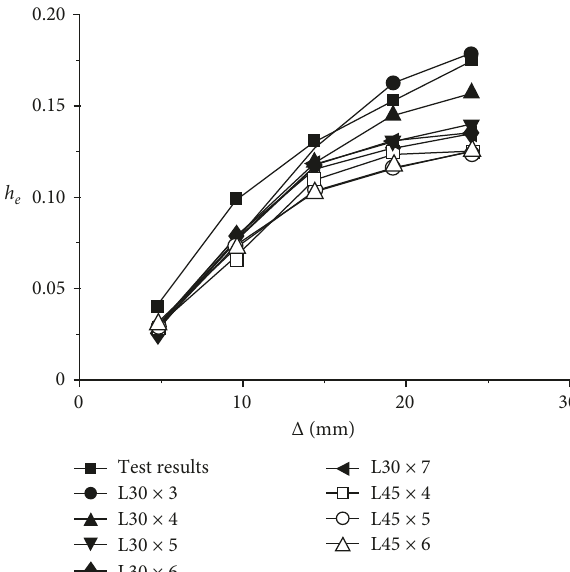
Figure 10: Equivalent viscous damping coefficient, h